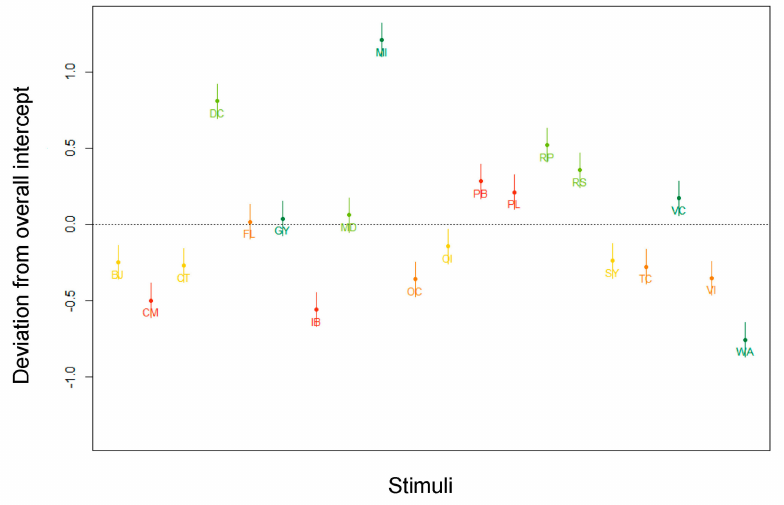
Figure 12. By-stimulus random intercepts in the subset of participants exposed to products with NFP. Abbreviations of the product names are explained in Figure 4 and in Appendix A (Table A1).